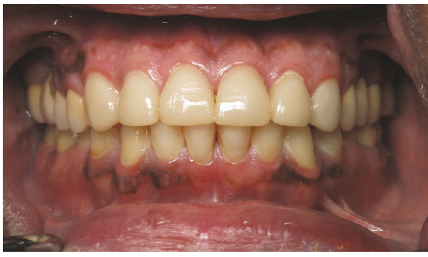
Figure 10: Six-month postoperative